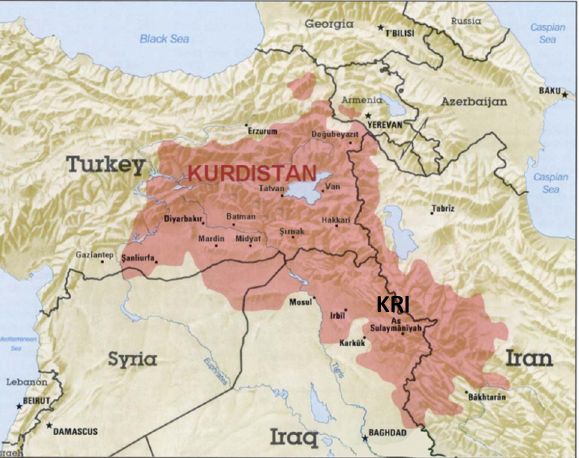
Figure 1. The approximate map of the Kurdish-populated region (“Kurdistan”) which includes parts of Turkey, Syria, Iraq and Iran (taken and adapted from https://www.bing.com/images/search for Kurdistan, latest accessed on 24 April 2022).